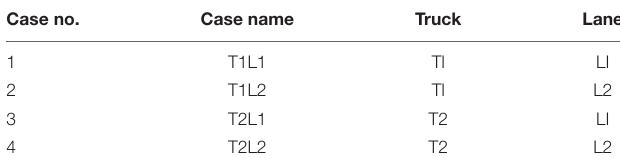
TABLE 2 | Static loading cases. Case